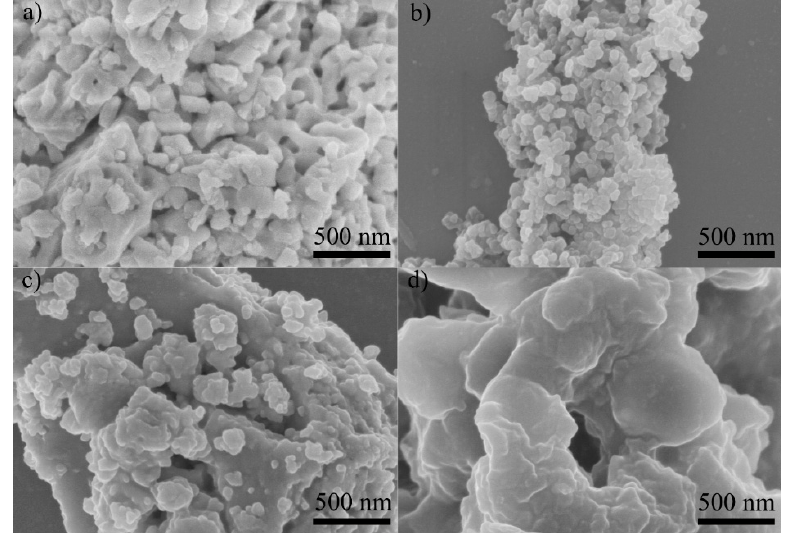
Figure 2. SEM micrographs for ( a ) p-800; ( b ) z5-800; ( c ) z5-900 and ( d ) z5-950 samples.